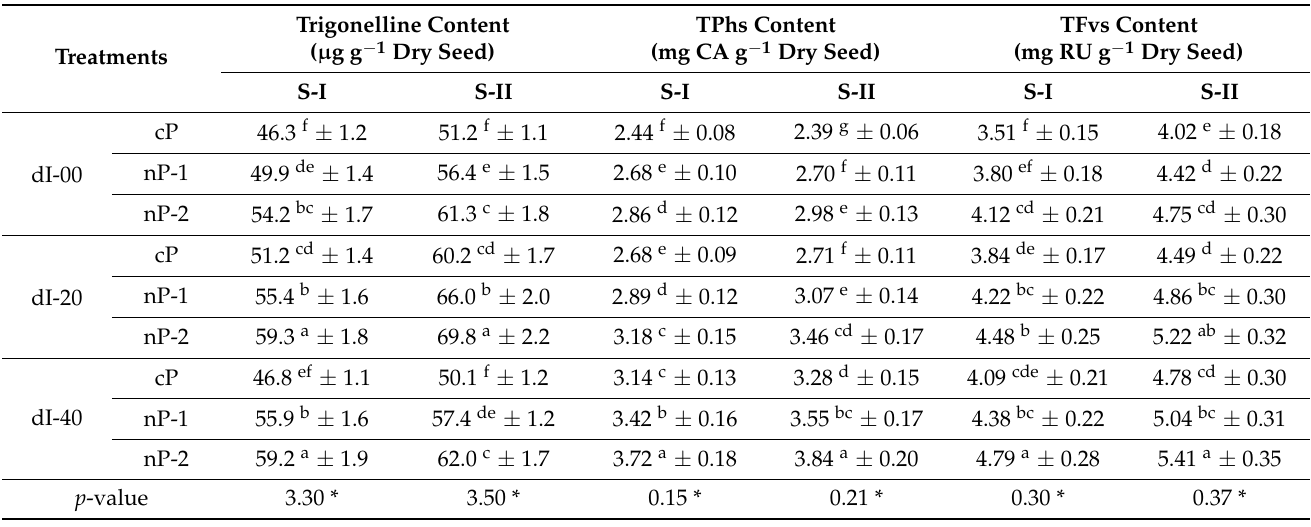
Table 8. The contents of trigonelline, total phenolics (TPhs), and total flavonoids (TFvs) of the seeds produced from fenugreek plants as affected by different irrigation water regimes and soil and foliar nourishing with phosphorus (P) during two growing